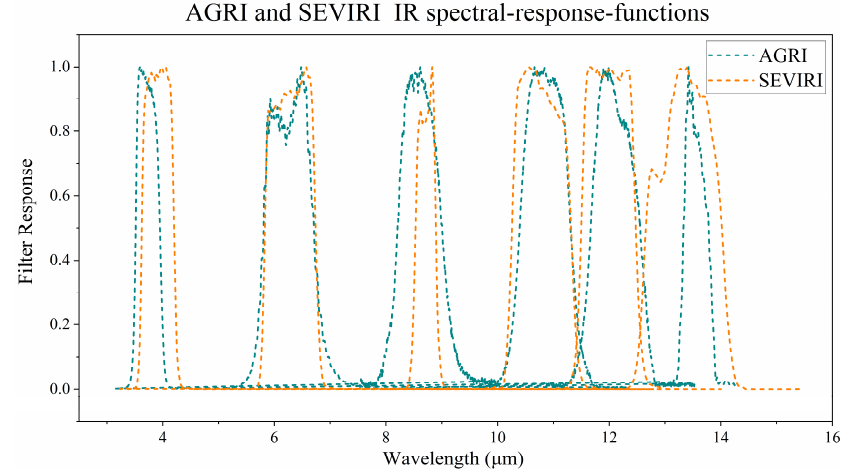
Figure 1. Spectral-response functions of six IR bands of MSG/SEVIRI and FY-4B/AGRI.